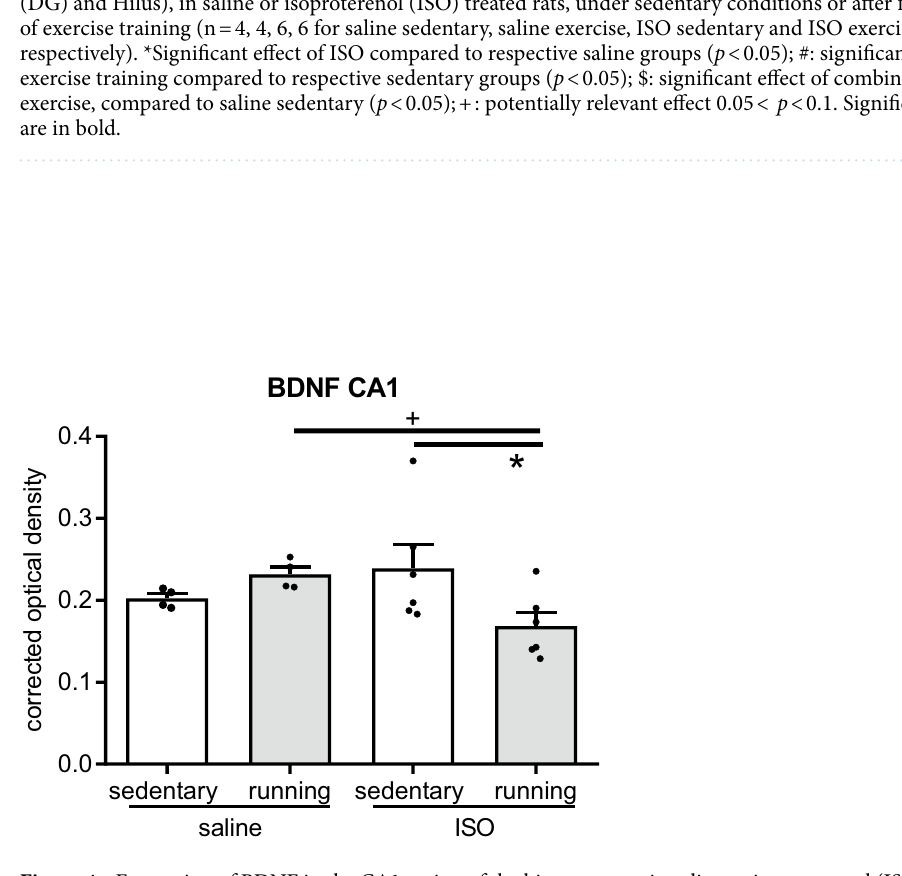
Figure 4. Expression of BDNF in the CA1 region of the hippocampus in saline or isoproterenol (ISO) treated rats, under sedentary conditions or after five weeks of exercise training, (n = 4, 4, 6, 6 for saline sedentary, saline exercise, ISO sedentary and ISO exercise rats, respectively). OD = optical density; *: significant difference between groups ( p < 0.05); + : p =